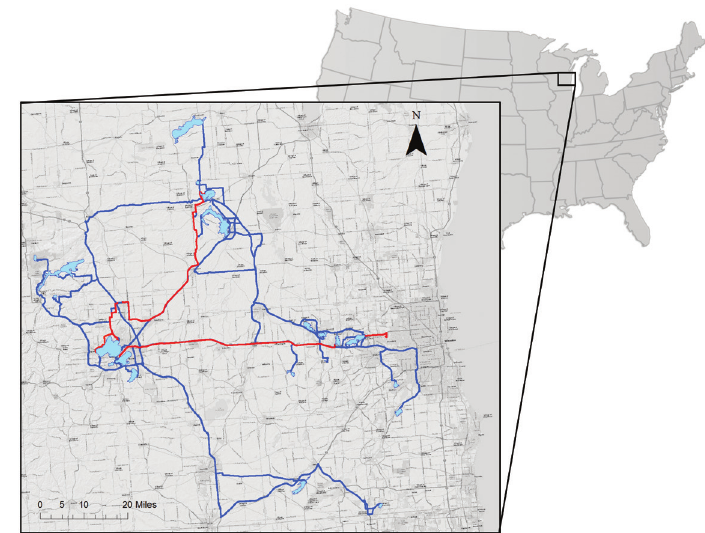
Figure 5. Road-routed movements by iBobber users between lakes in the greater Milwaukee, WI area. Movements between lakes with invasive species present are indicated by blue routes while movements from an invaded lake to a non-invaded lake are indicated by red